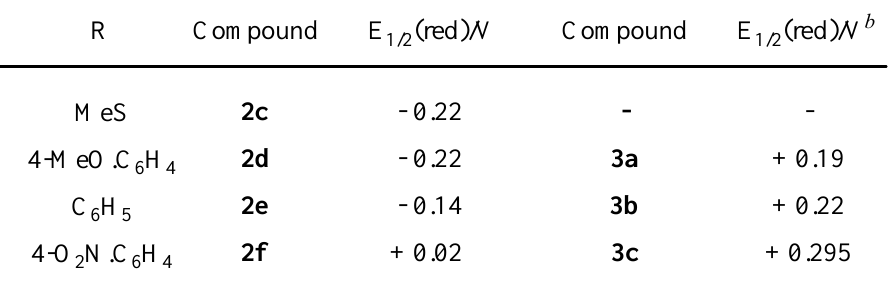
Table 3 The E (red) value a for the 1,2,3-dithiazolium perchlorates 2c - f and 1/2 for the 1,2,3,5-dithiadiazolium salts 3a-c